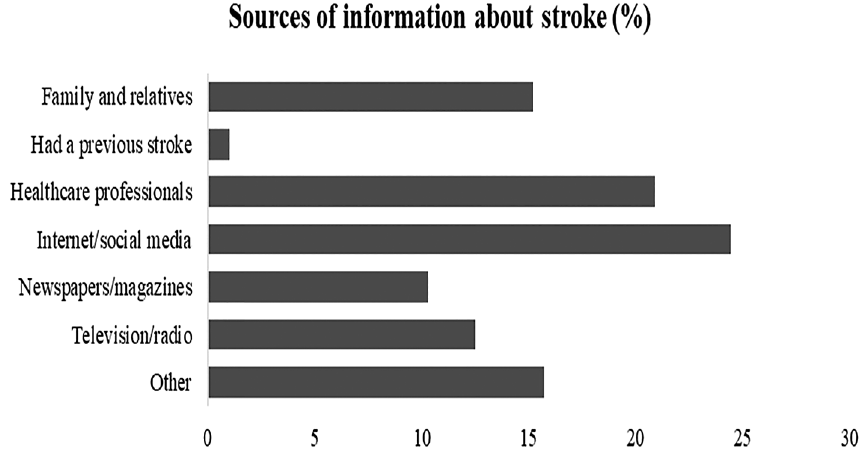
Figure 4. Evaluation of sources of information about